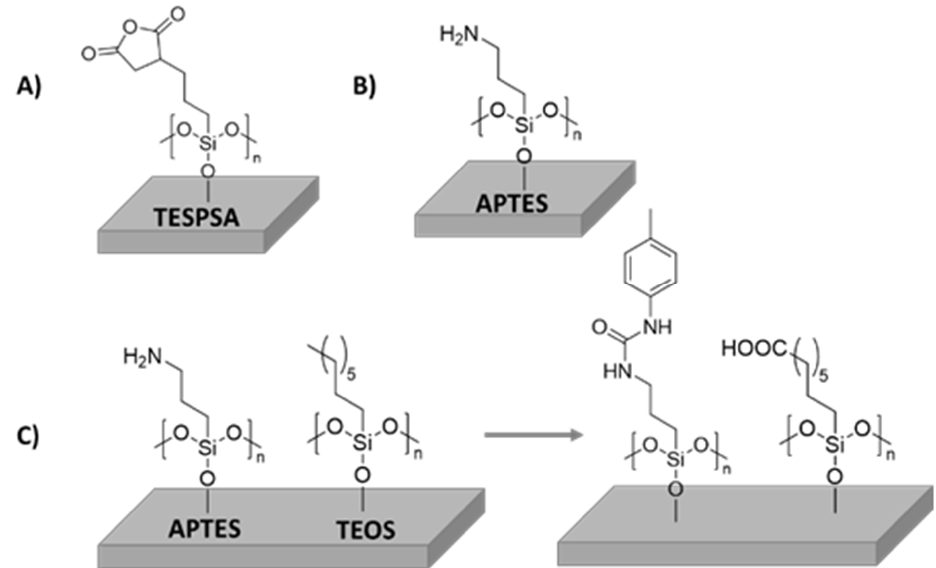
Figure 4. Schematic representation of silanes covalently immobilized onto Ti surfaces: ( A ) TESPSA immobilization onto Ti dental implant, ( B ) APTES immobilization onto Ti6Al4V alloy and ( C ) APTES and TEOS immobilization onto Ti6Al4V and their further functionalization .